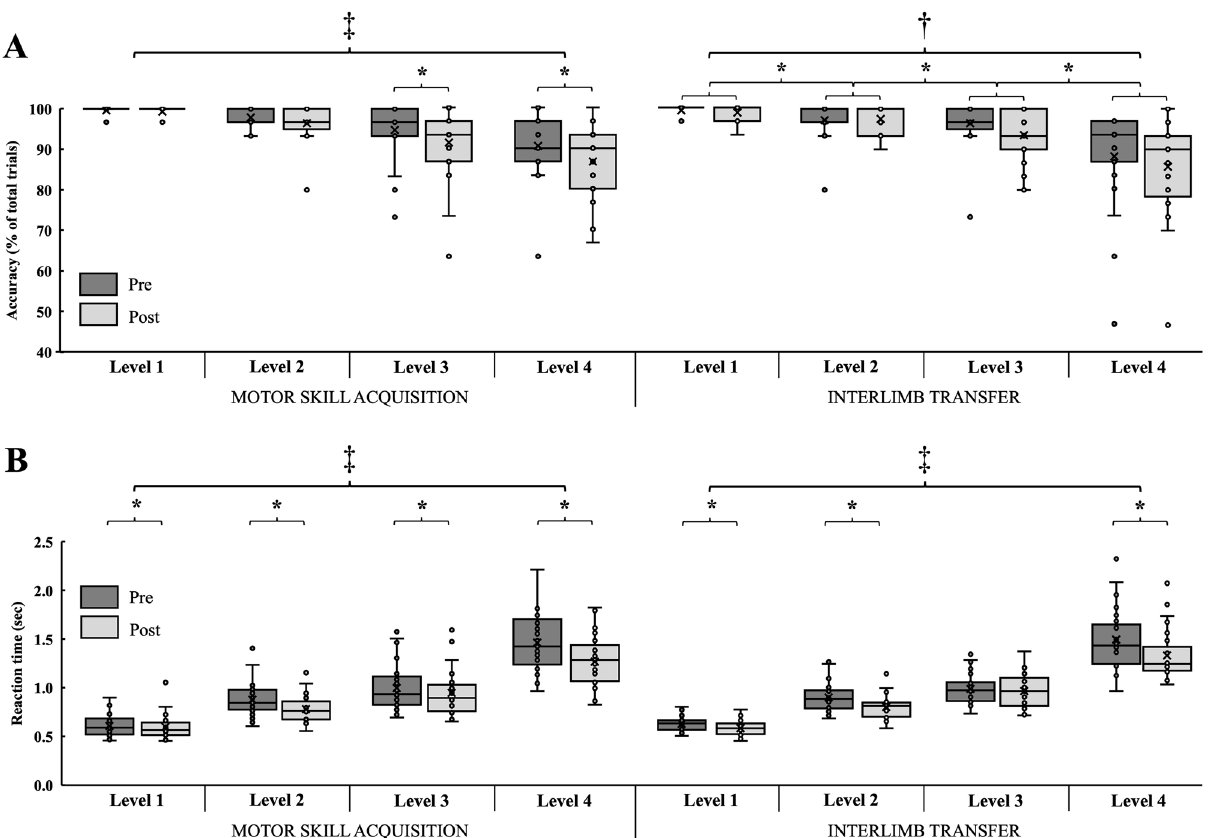
Figure 4. Motor skill acquisition and interlimb transfer at different sequence complexities after dominant hand motor sequence practice. Panel ( A ) Participants performed the motor sequence tasks with less accuracy at level 3 and level 4 after the practice with their practicing dominant hand, regardless of handedness. Moreover, motor sequence errors increased with the increase in sequence complexity in the non-practicing hand. Panel ( B ) The practice produced motor skill acquisition indicated by a decreased RT at each level post versus pre-test. In addition, the motor skill practice also induced interlimb transfer of decreased RT at levels 1, level 2, and level 4, regardless of handedness. Results also suggest an interlimb transfer of decreased MT at each level, regardless of handedness. The boxplots show the median, the upper, and lower quartiles, and the min and max value of the groups. “ × ” within the boxplot represents the mean line. ‡ time × sequence complexity interaction effect; † main effect of sequence complexity, * p < 0.05.